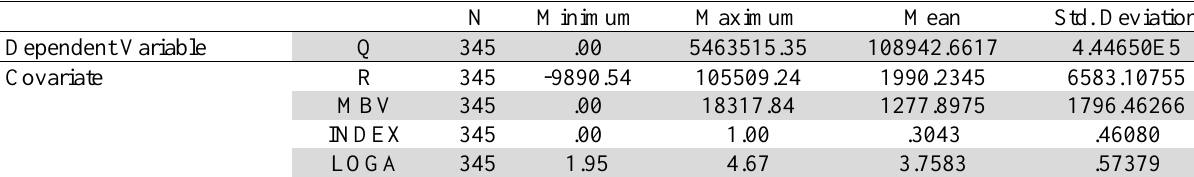
The summary of GLM method